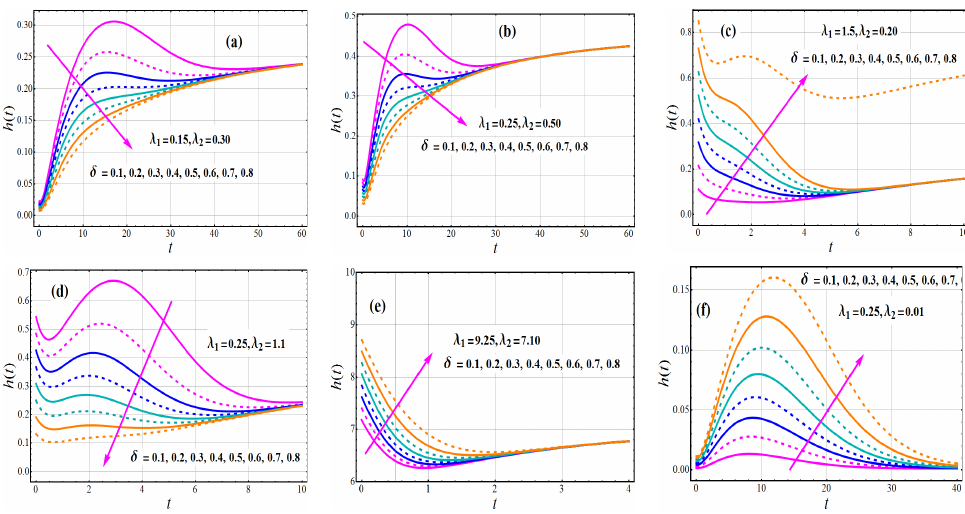
$ ) for (cid:21) 1 ; (cid:21) 1 and (cid:14) . j